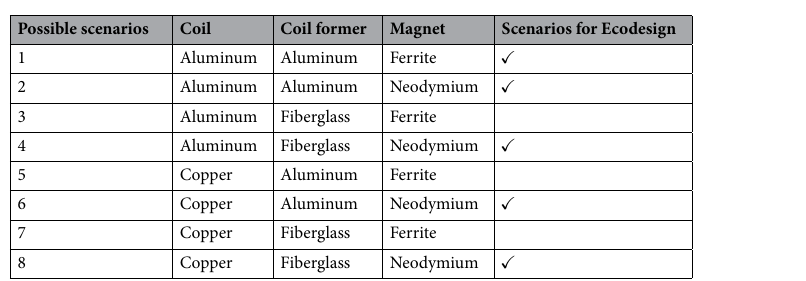
Table 3. Combination of components for Ecodesign